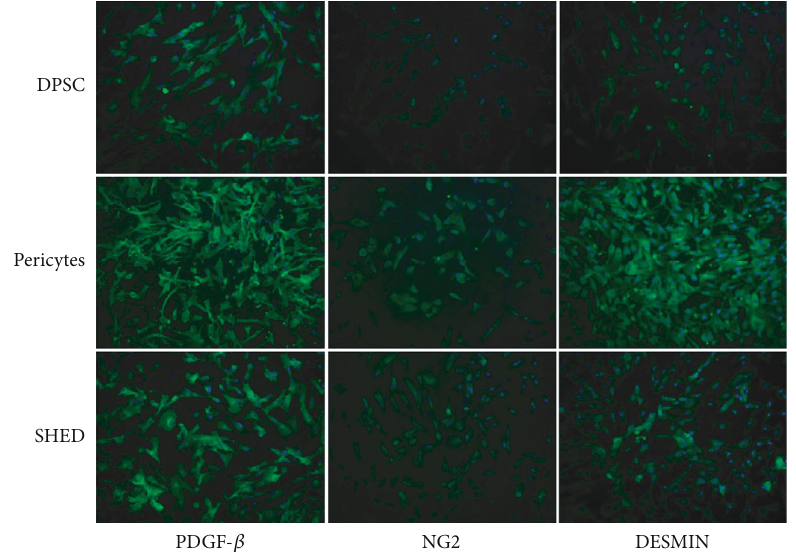
Figure 8: Western blot results of PDGFR- β , α -SMA, NG2, and DESMIN protein expression levels in SHED, DPSC, and pericytes cultured in PM, α -MEM, and MGM medium for 14